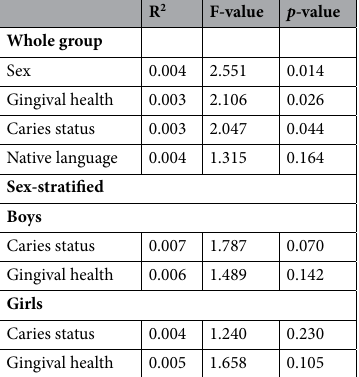
Table 2. Determinants of beta diversity in whole group, and separately in boys and girls. PERMANOVA analysis for the beta diversity using Bray Curtis dissimilarity index among the study participants adjusted for age, gender, BMI z-score, native language, and gingival